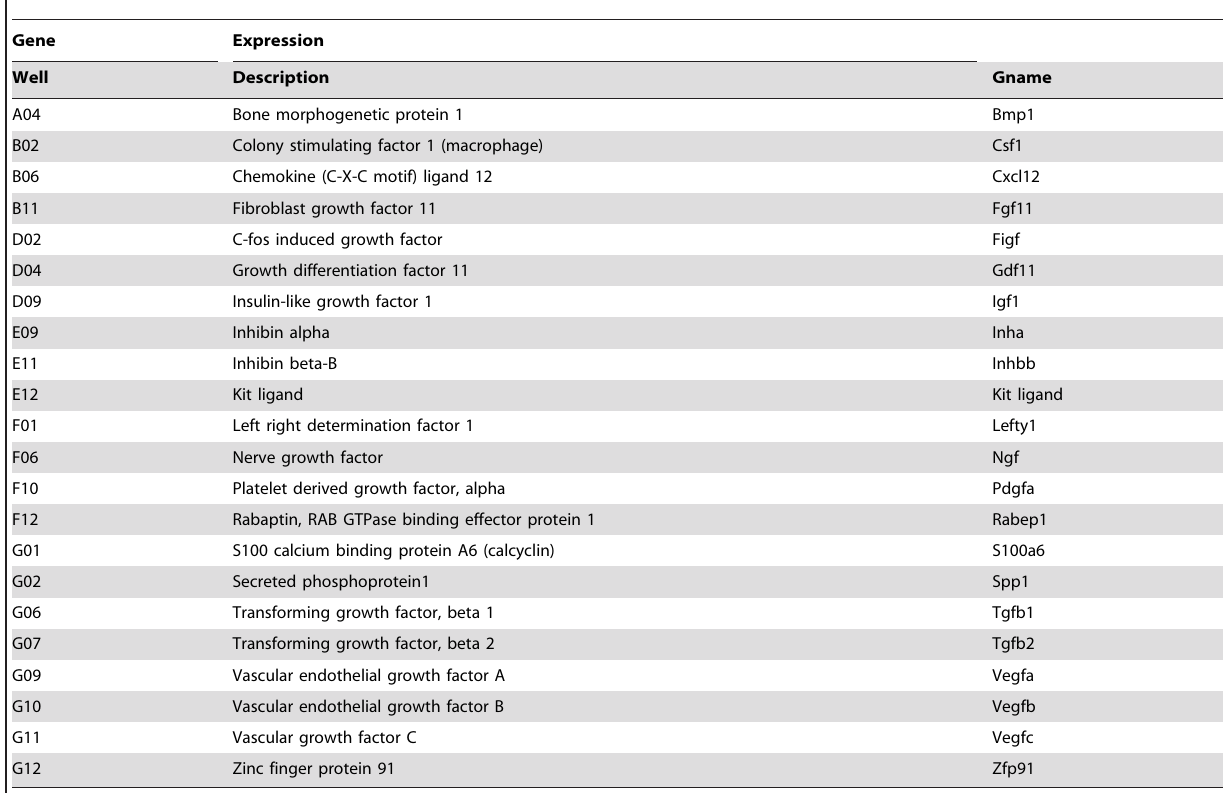
Table 1. High expression of growth factor associated genes in mouse heart derived Sca-1 + /CD31 2 cells.